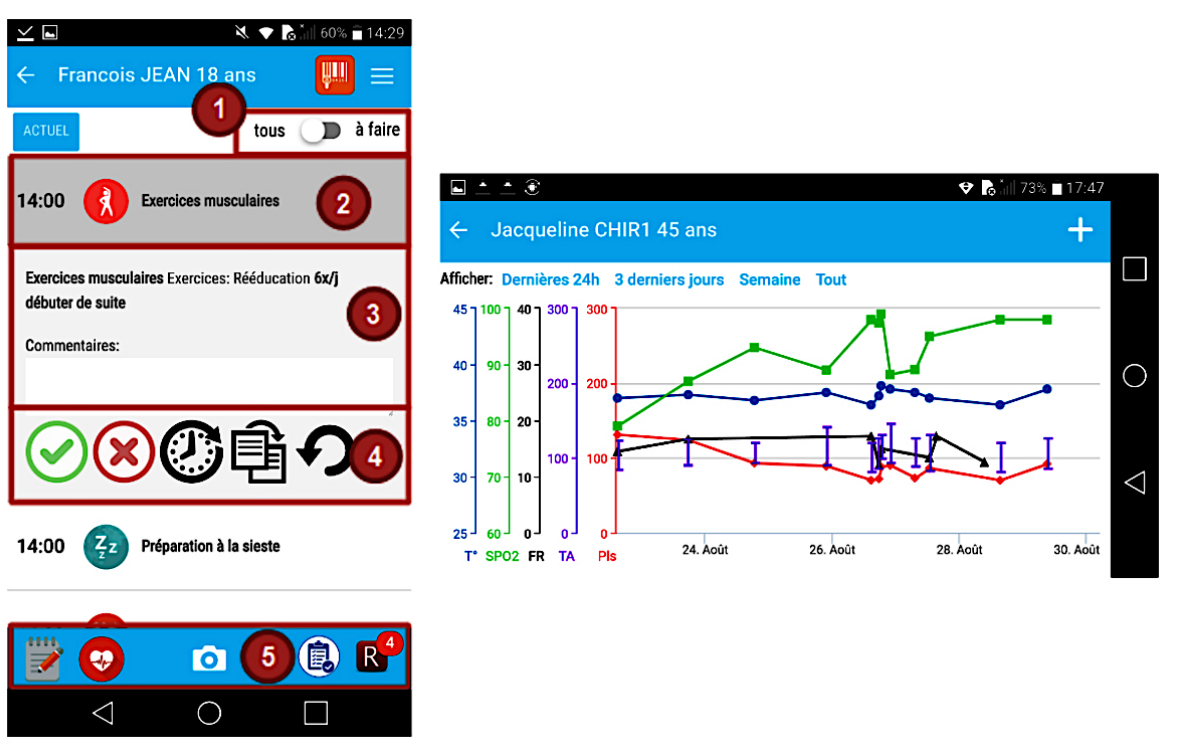
Figure 1. Main screen and vital sign screen of the BEDSide Mobility